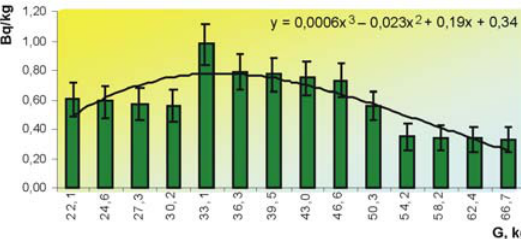
90 Sr activity and biomass in